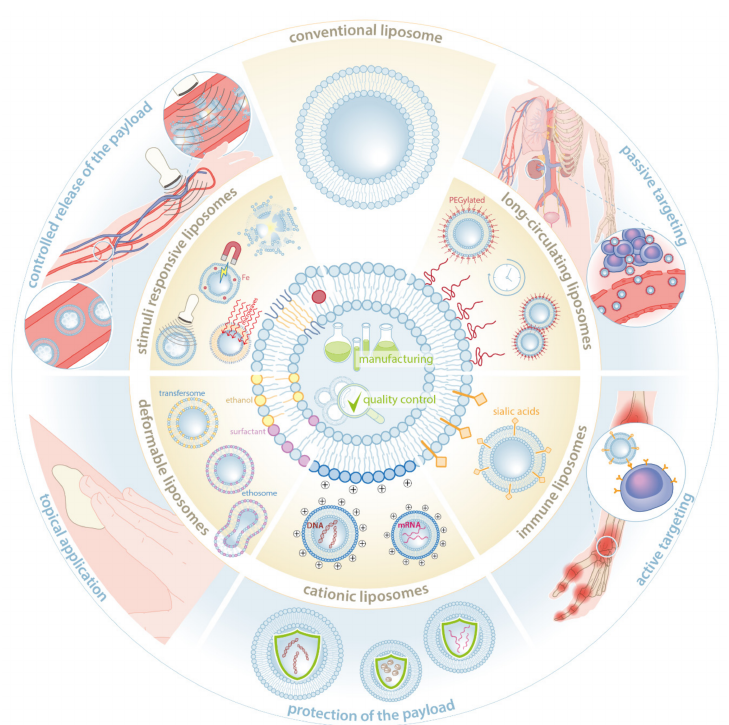
Figure 1. Summary of the features available for the modification of liposomes in order to provide beneficial clinical use. Five categories of liposome features currently available are presented in the middle ring of the figure, which include long-circulating liposomes, immune liposomes, cationic liposomes, deformable liposomes, and stimuli responsive liposomes. In the outer ring, the associated clinical benefits are illustrated, which include passive targeting, active targeting, protection of the payload, topical application, and controlled release of the payload, respectively. For targeting of specific pathologies or cells, several features may be combined to enhance clinical efficiency and/or safety in treatment of (severe) inflammatory